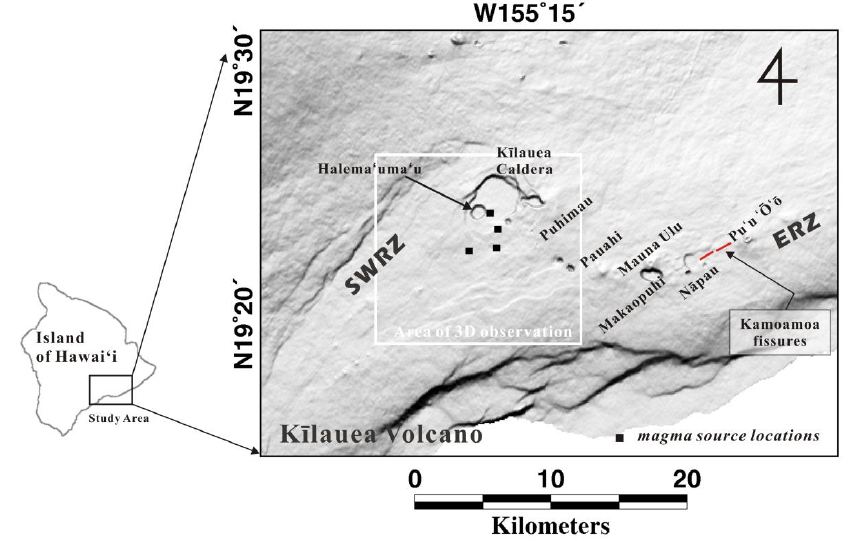
Figure 1. Shaded relief map of the Kīlauea volcano, Hawai‘i, including the summit and rift zones. The white box outlines the area where 3D displacements of surface deformation were measured. Small squares indicate the magma source locations beneath Kīlauea’s summit. The red line between Nāpau and Pu‘u ‘Ō‘ō craters represents the Kamoamoa fissure. ERZ, East Rift Zone; SWRZ, Southwest Rift